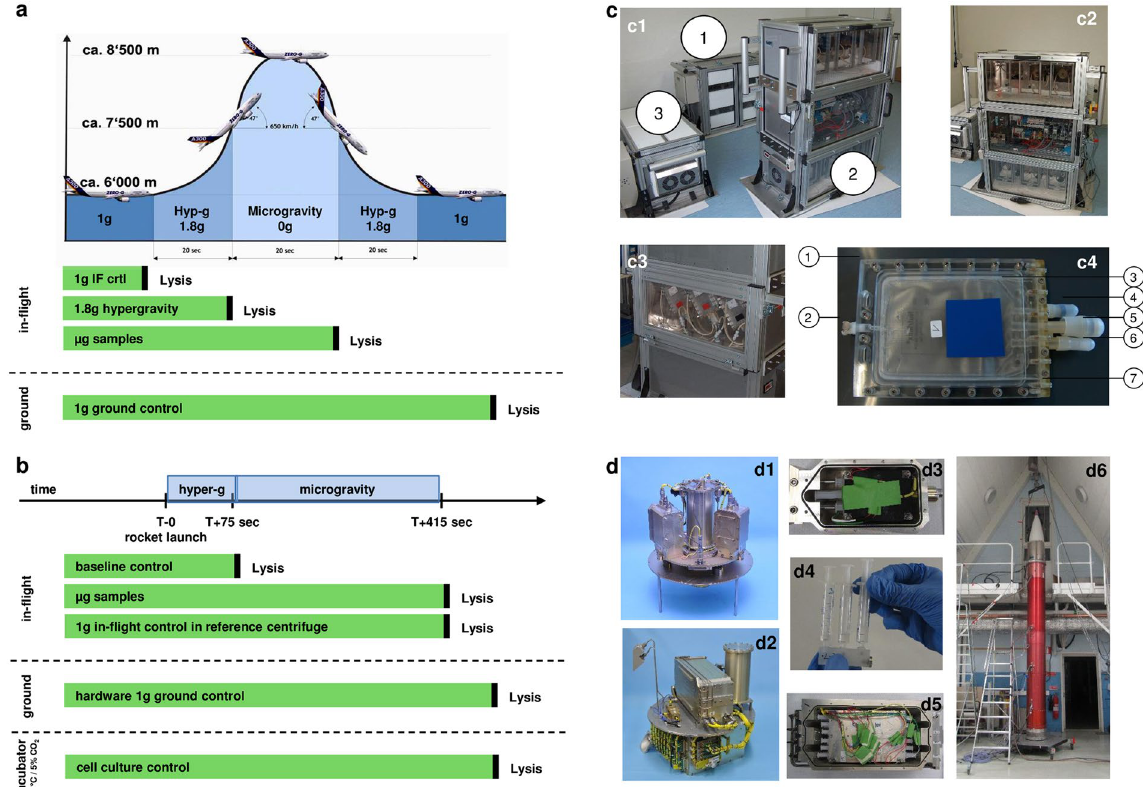
Figure 1. Experiment design of the parabolic flight (23 rd DLR PFC) and suborbital rocket (TEXUS-51) experiments. ( a ) During the 23 rd DLR PFC Jurkat T cells were analyzed before and during the first parabola. 1 g in-flight control (1 g IF ctrl) samples were lysed 5 min before the first parabola, 1.8 g hypergravity samples at the end of the first 1.8 g phase, and microgravity samples at the end of the first microgravity phase. After the flight, 1 g ground controls were performed in the experiment hardware inside the aircraft 66 . ( b ) During the TEXUS-51 sounding rocket mission Jurkat T cells were lysed at time point T + 75 s to monitor the hypergravity and vibration effects of the rocket launch. Microgravity samples and 1 g in-flight reference centrifuge control samples were lysed after 415 s post-launch. Additionally, hardware 1 g ground controls as well as cell culture controls were lysed post-flight approximately 15 min after the rocket launch. ( c ) In-flight experiment system for parabolic flights on board the Airbus A300 ZERO-G. c1 Experiment hardware structure which consists of an incubator rack to store the cell containers at 37 °C before the experiment (1), an experiment rack, in which all technical aggregates are accommodated for the execution of the experiment and where the living cells are processed during altered gravity (2), and a cooling rack to store all cell containers at 4 °C after the injection of the lysis solution until landing (3). c2 Structure of the working rack, rear side. In the upper third (4 °C) are three separate hose pumps which pump the lysis solution into the cell containers, controlled by the unit inside the middle third, which also carries all electrical connections and fuse elements. All liquids are sucked under exclusion of air. In the lower part (36.5 °C) are three separate hose pumps which pump the medium into the cell containers c3. Structure of the working rack, front side, waterproof working space with cell containers. c4. Double-walled, liquid-proof cell container. A maximum of 54 container can be accommodated during one flight. 1 = plastic container, 2 = air valve, 3 = internal sterile cell culture bag (Nutrimix, 0.25 l), 4 = connector 1 (medium), 5 = connector 2 (lysis buffer), 6 = connector 3 (port for filling of cells, performed pre-flight), 7 = plastic flange. ( d ) In-flight experiment system for the suborbital ballistic rocket flight of the TEXUS-51 payload. TEXUS consists of a VSB-30 engine (not shown) and of the payload structure (d6). Sets of three sterile syringes were filled with cell suspension, medium, and lysis buffer connected by a T-piece with small plugs at the outlet ports to prevent premature contact of the fluids (d4). The syringe systems are accommodated in tempered and vacuum-resistant containers (d3, d5) at the static (d2) or centrifuge (d1)